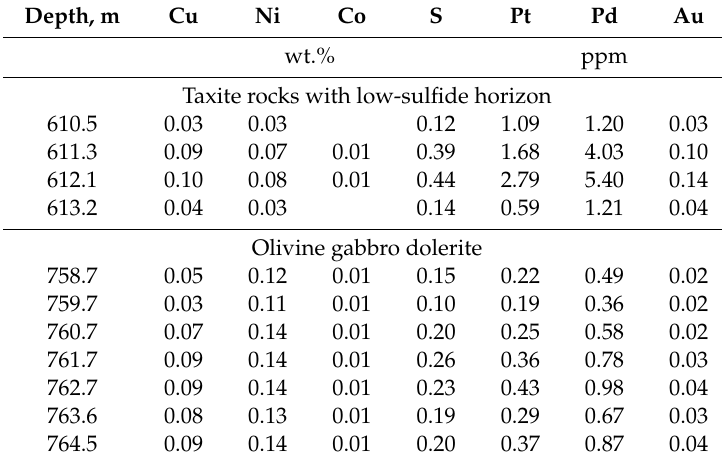
Table 2. Contents of ore elements and S in the rocks of borehole PH-72.